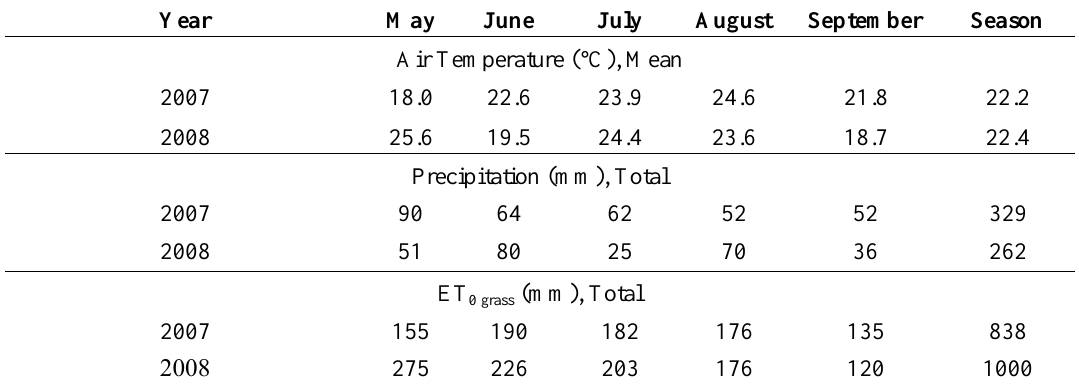
Table 1. Seasonal and monthly air temperature, precipitation and ET Plains ET network weather station near the study site